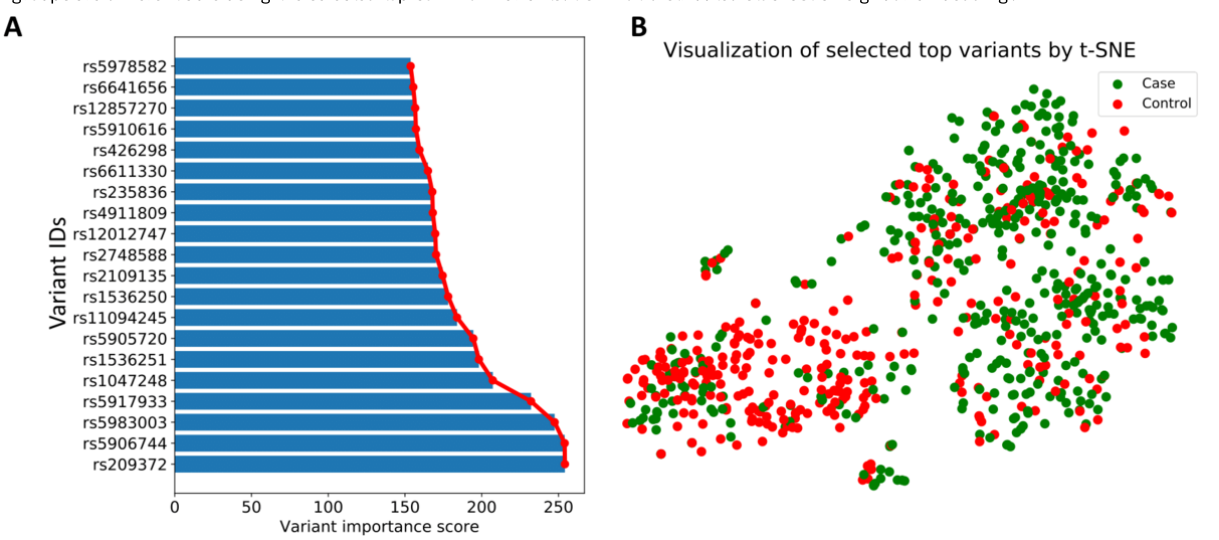
Figure 2. A. Variants with high relative importance scores in chi-square test. The Y-axis corresponds to variant IDs of these variants, and the X-axis corresponds to the relative importance values of the corresponding variants. B. Visualization of the top 100 selected significantly common variants using t-distributed stochastic neighbor embedding. Different colors represent different classes (ie, case and control). This visualization indicates that the 2 groups are differentiable using the selected top common variants. t-SNE: t-distributed stochastic neighbor